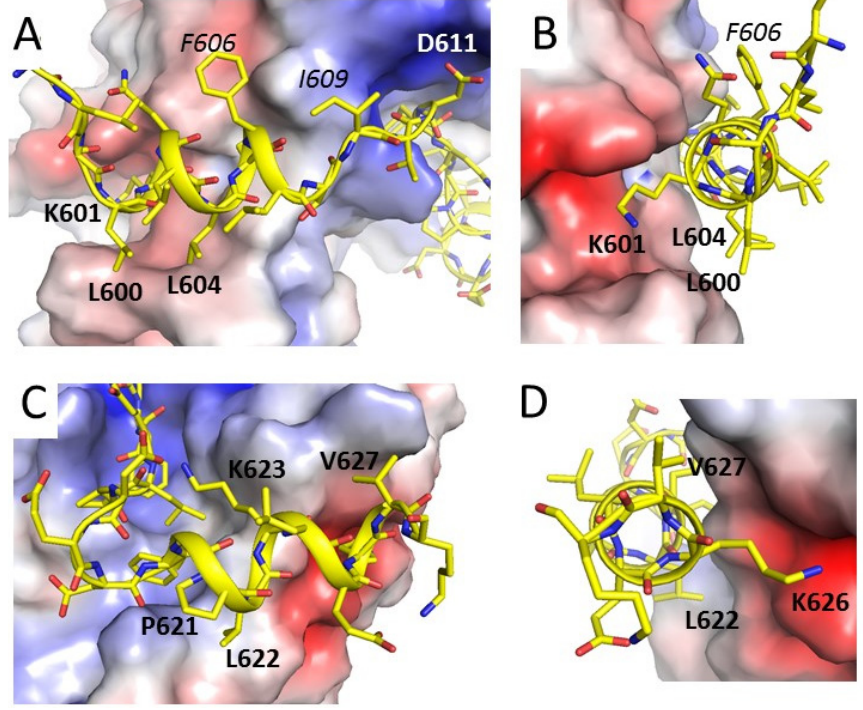
Figure 4. Interactions of flanking helixes with MRG. ( A , B ) Orthogonal views of α H1, shown in cartoon and stick representation, and interactions with the MRG domain shown in surface representation and color-coded accordingly to electrostatic potential; ( C , D ) two orthogonal views of α H2.